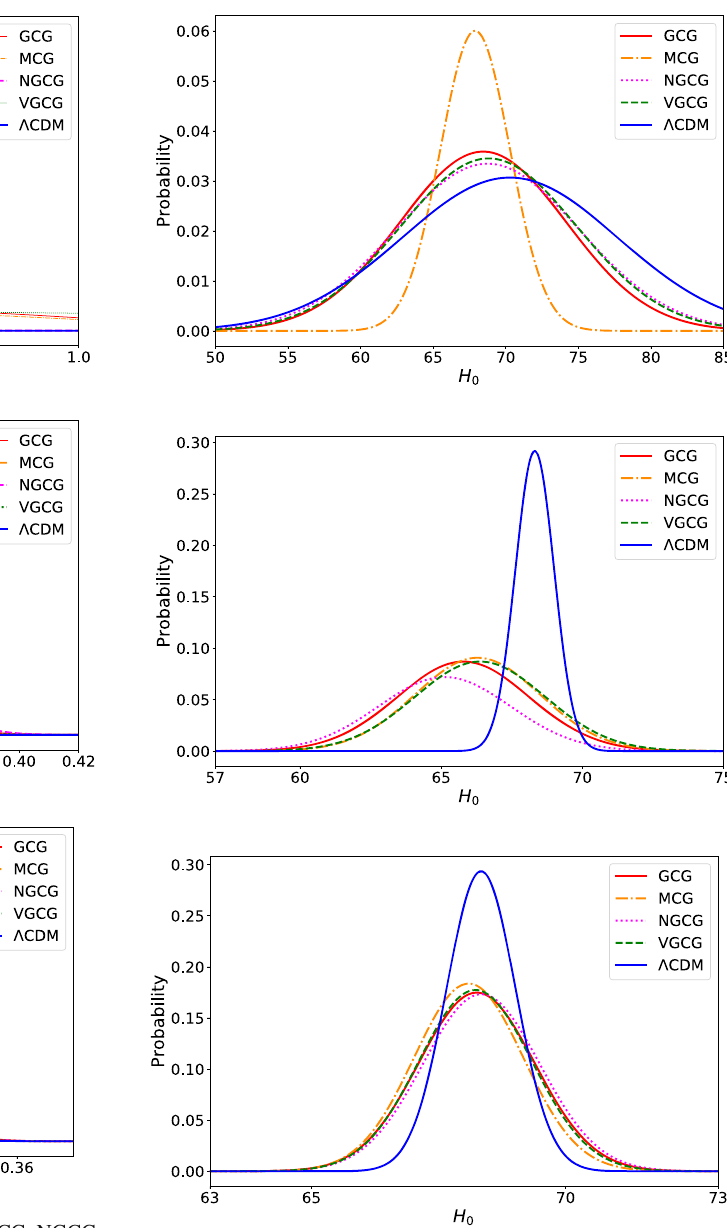
Fig. 7 The posterior distributions of H 0 for the GCG, MCG, NGCG, VGCG and Λ CDM models, with the standard candles, standard rulers and combination data from the top to the bottom. We adopt the posterior distributions of H 0 from Table